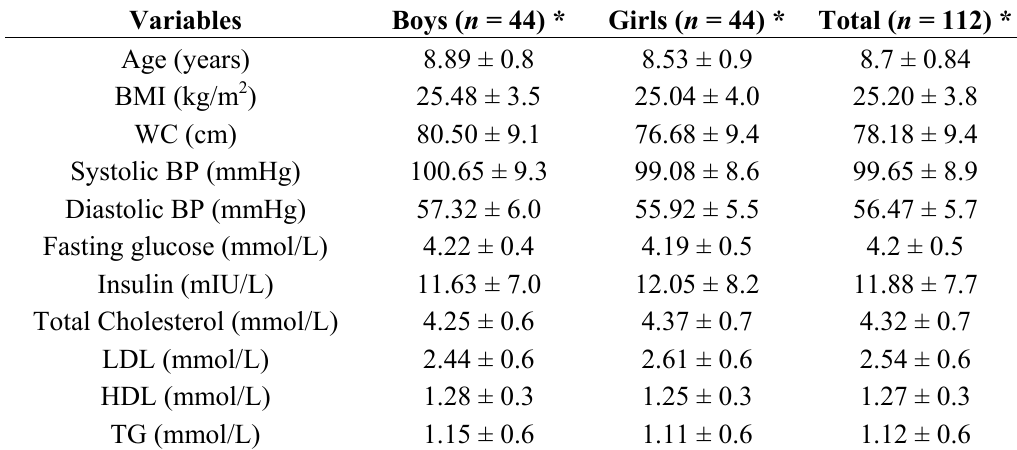
Table 2. Characteristics of the children at baseline.